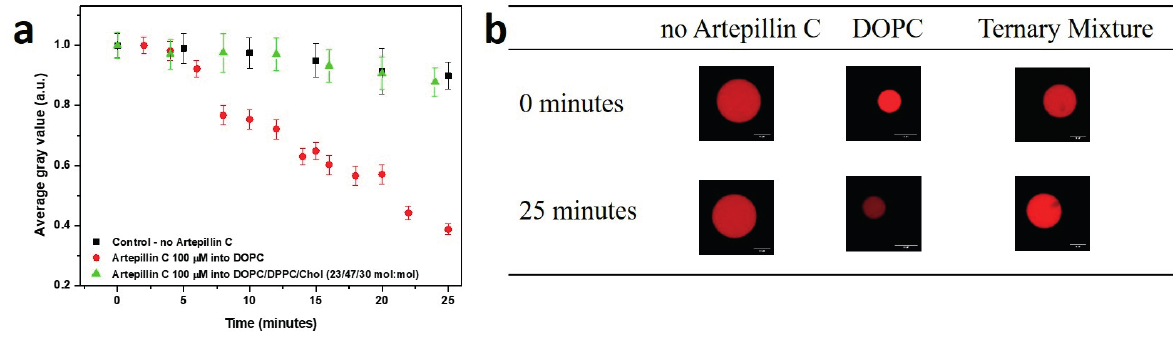
Figure 3 - a) AlexaFluor-488 release kinetics from inside the GUV membrane models after insertion of Artepillin C, as evaluated by confocal fluorescence microscopy. Black squares: control – no Artepillin C; red dots: 100 µM of Artepillin C into fluid-phase GUV formed of DOPC; green triangles: 100 µM Artepillin C into liquid-ordered/liquid-disordered GUVs consisting of a ternary mixture of DOPC/DPPC/cholesterol (23/47/30 mol:mol:mol). b) Representative images of DOPC-GUVs and GUVs consisting of a ternary mixture of DOPC/DPPC/cholesterol (23/47/30 mol:mol:mol) at the initial (0 minutes) and final (25 minutes) fluorescence intensity